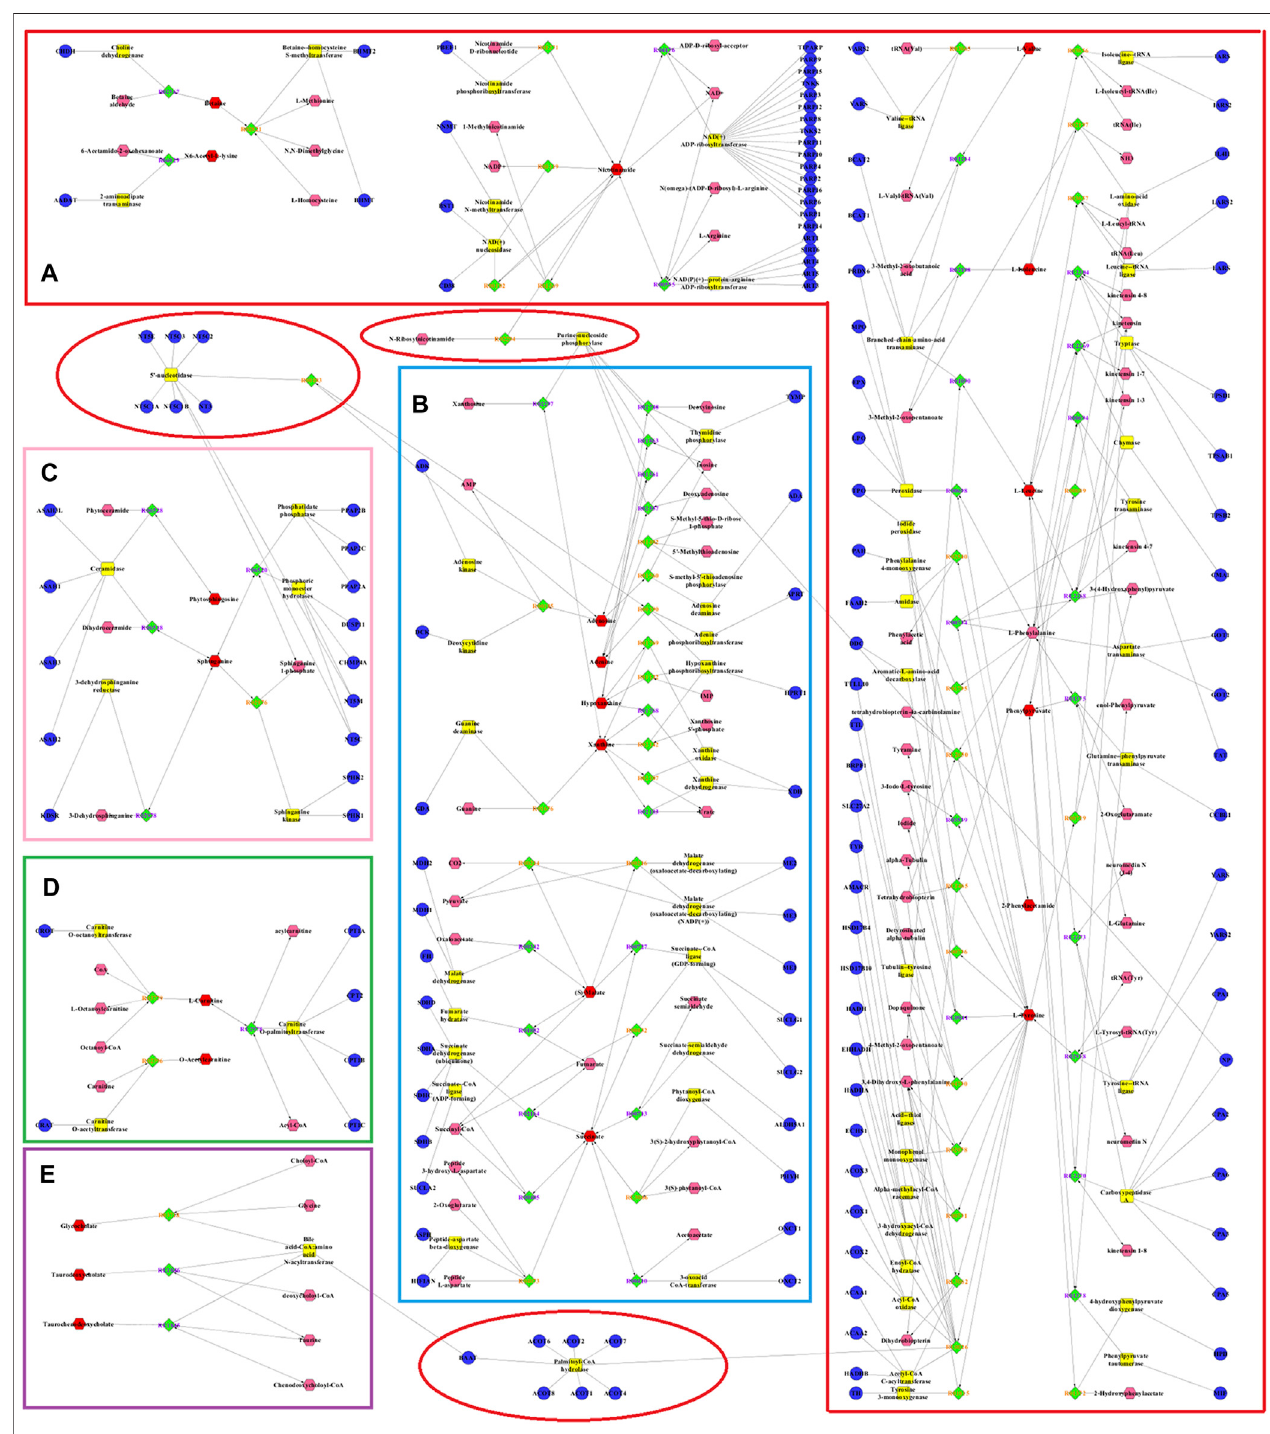
FIGURE 8 | Metabolic networks involved in enzymes and genes were established based on the differential metabolites in both CUMS and healthy rats following PBR treatment. The metabolic networks of amino acid metabolism (A) , energy metabolism (B) , sphingolipid metabolism (C) , β -oxidation of fatty acid (D) and bile acid metabolism (E) .